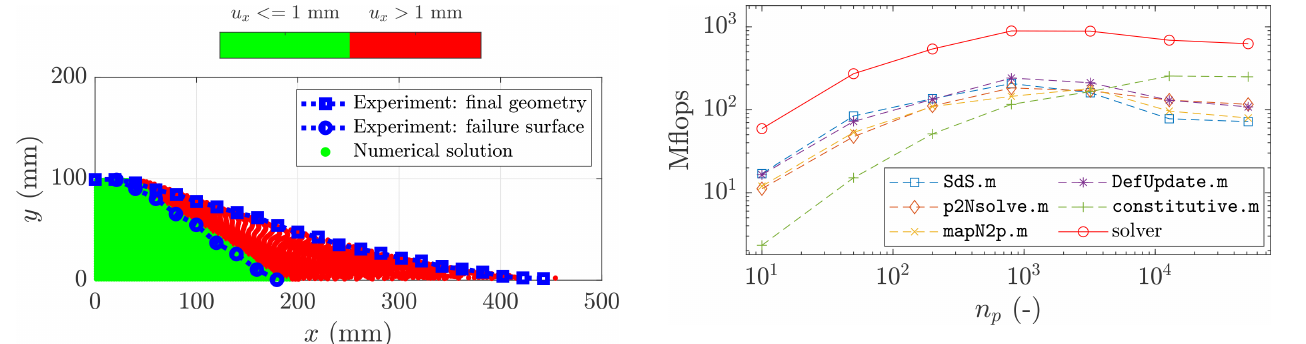
Figure 17. Final geometry of the collapse: in the intact region (hor- izontal displacement u x < 1mm), the material points are coloured in green; in the deformed region (horizontal displacement u x > 1mm), they are coloured in red and indicate plastic deformations of the initial mass. The transition between the deformed and unde- formed regions marks the failure surface of the material. The ex- perimental results of Bui et al. (2008) are depicted by the blue dot- ted lines. The computational domain is discretized by a background mesh made of 320 × 48 quadrilateral elements with n p = 4 per ini- tially populated element, i.e. a total n p = 12800 material points dis- cretize the aluminium assemblage.